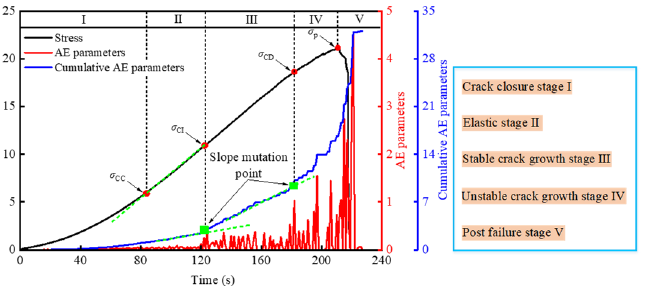
Figure 6. Schematic diagram of the determination method of feature threshold during loading.